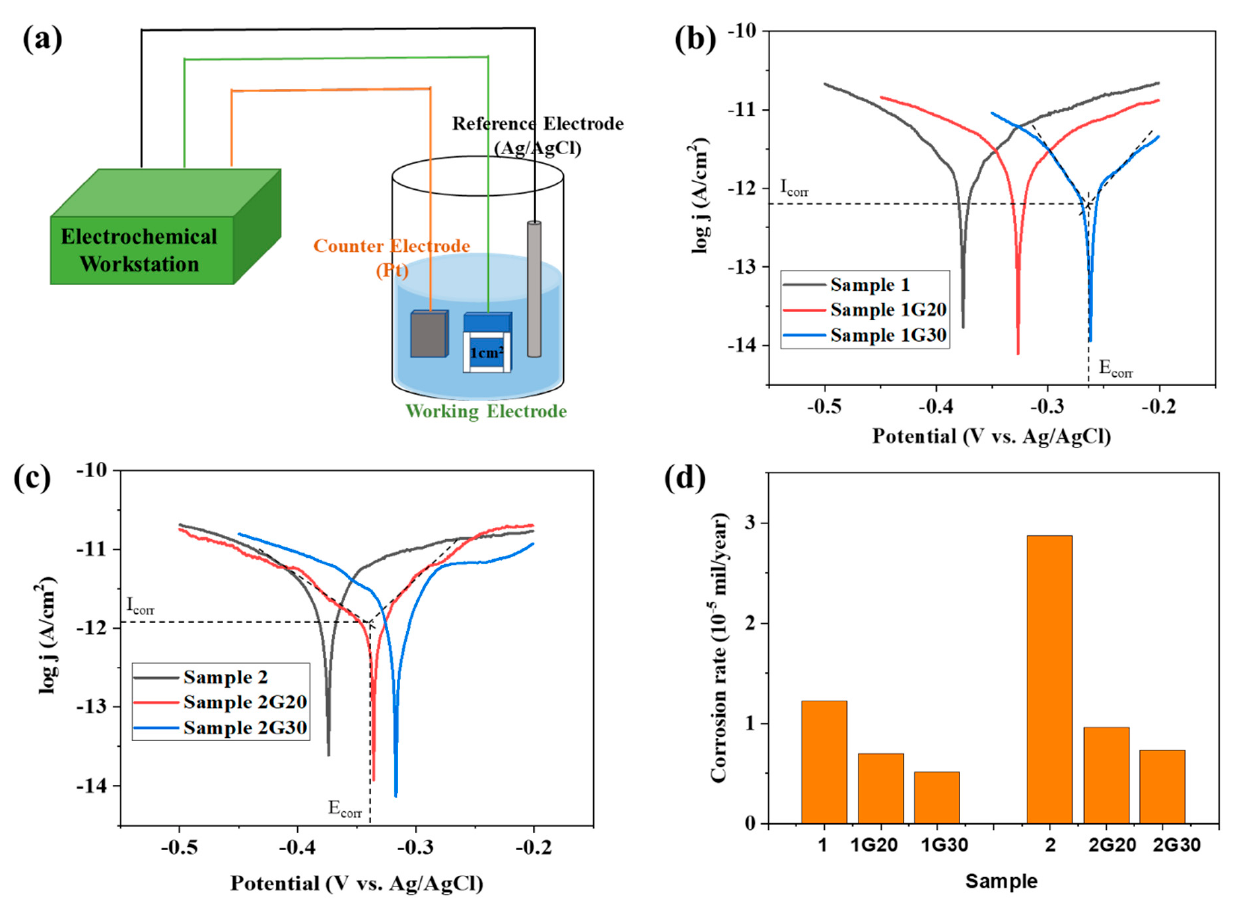
Figure 5. ( a ) Scheme of corrosion electrochemical test diagram of ACF and G/ACF samples. ( b , c ) Tafel plots of ACF and G/ACF samples. ( d ) Corrosion rates of ACF and G/ACF samples.